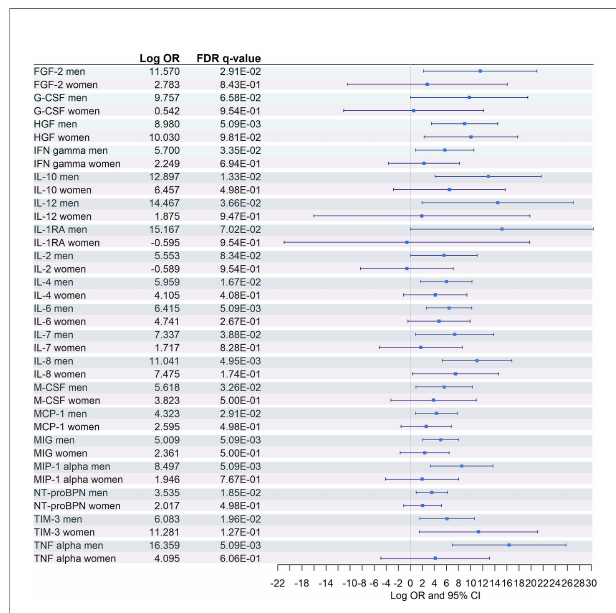
FIGURE 9 | Sex-speci fi c pairwise comparison of cytokines. Logistic regression, adjusted for age, was used for each sex separately. The False Discovery Rate or FDR was used to cope with multiple testing, q-values are